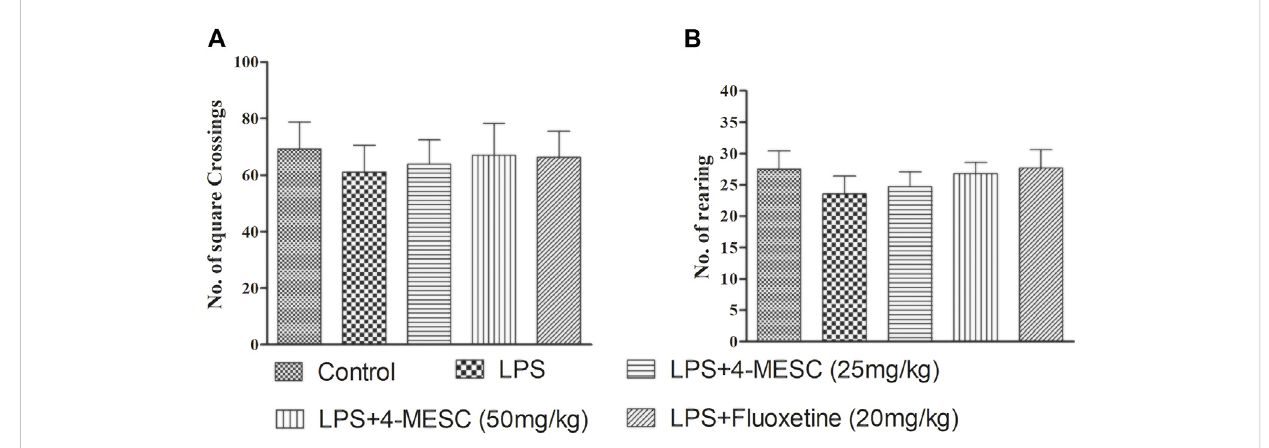
FIGURE 3 Effect oflipopolysaccharide(LPS)and 4-methylesculetinonautonomousactivity wereevaluated byan open- fi eldtest(OFT). (A) No.ofcrossing. (B) No. of rearing. Data are expressed as mean ± SD. The results showed no difference between the different